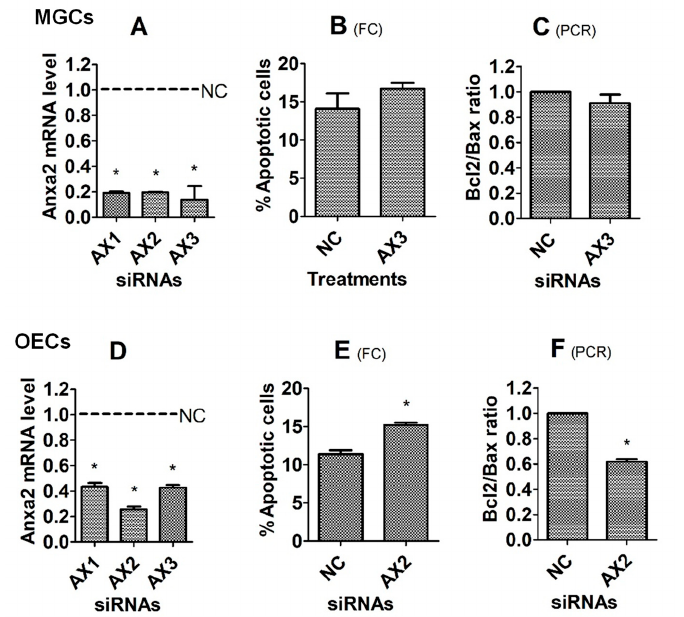
Figure 6. Effects of knocking down Anxa2 on corticosterone-induced apoptosis of MGCs and OECs. Graphs ( A , D ), ( B , E ) and ( C , F ) show Anxa2 mRNA level, percentage of apoptotic cells, and the ratio of Bcl2/Bax mRNA, respectively, after MGCs or OECs were transfected with negative control (NC), Anxa2 siRNA-1 (AX1), -2 (AX2) or -3 (AX3). While the mRNA level was revealed by RT-PCR, the percentage of apoptotic cells was measured by flow cytometry (FC). Each treatment was repeated 3 times, with each replicate including cells from 2 wells of a 6-well plate from 12 mice (MGCs) or from 4 mice (OECs). * Indicates significant difference ( p < 0.05) from NC cells. In graphs ( B ) and ( E ), the percentages of apoptotic cells included both early and late apoptotic cells. In graphs ( C ) and ( F ), the ratio of Bcl2/Bax mRNA in NC cells was set to one, and the ratio in AX3 or AX2 cells was expressed relative to it.